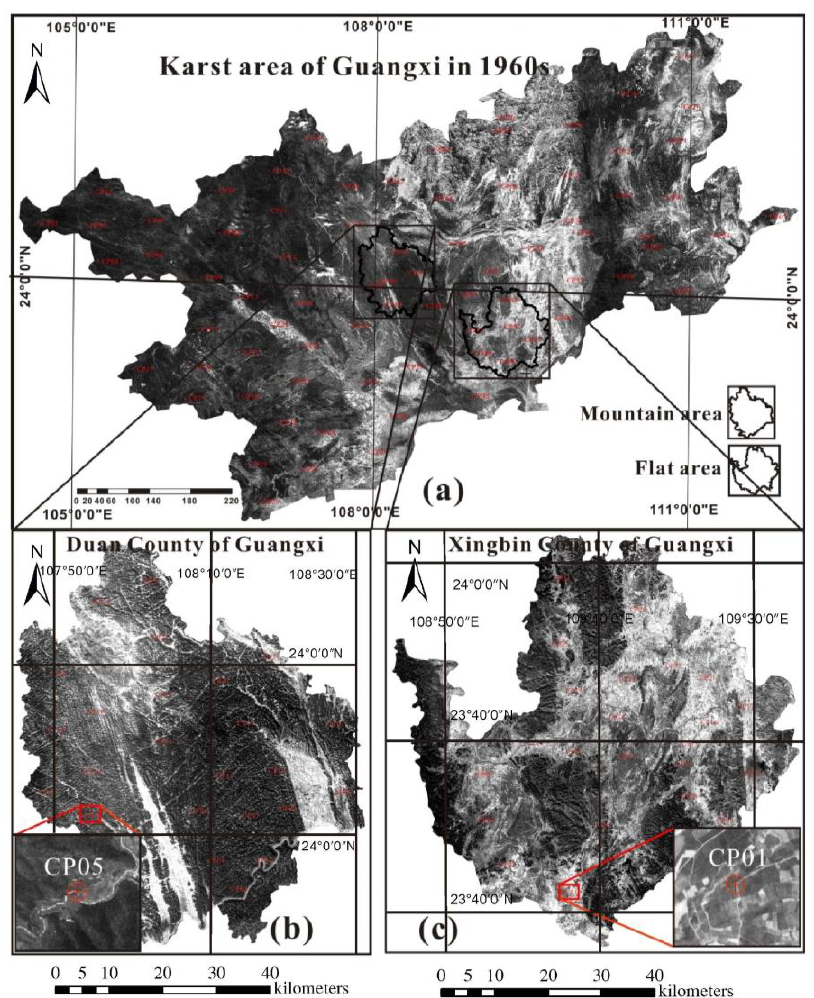
Figure 12. Mosaic results: ( a ) a completely assembled 1960s mosaic of the Guangxi karst area; ( b ) accuracy validation in a mountainous area; and ( c ) accuracy validation in a flat area. Table 2. Final accuracies of the assembled DISP image map in the study area.